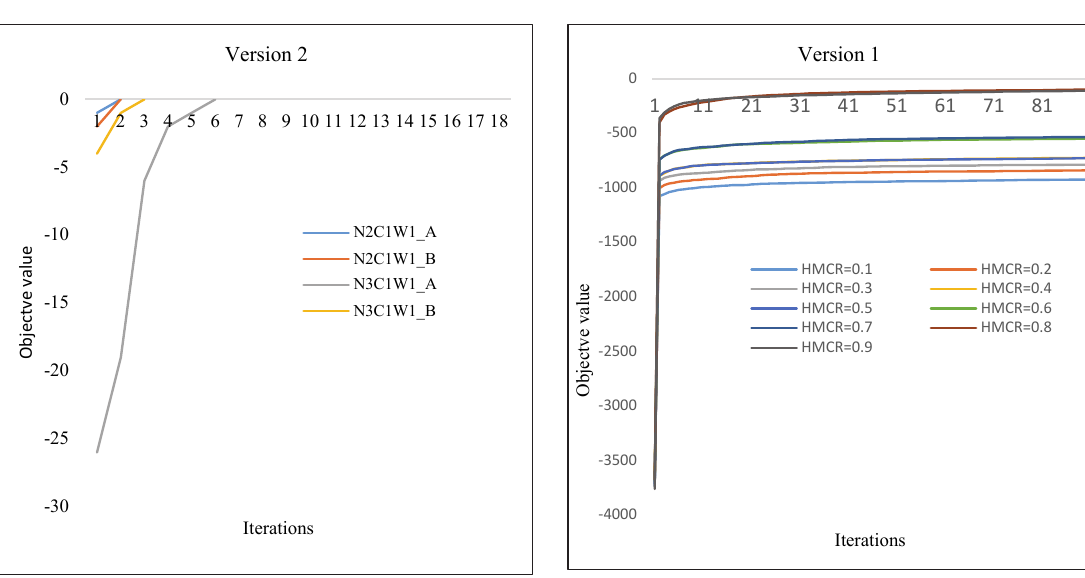
Fig. 8. Performance of version 1 algorithm for sample datasets with 100 and 200 objects